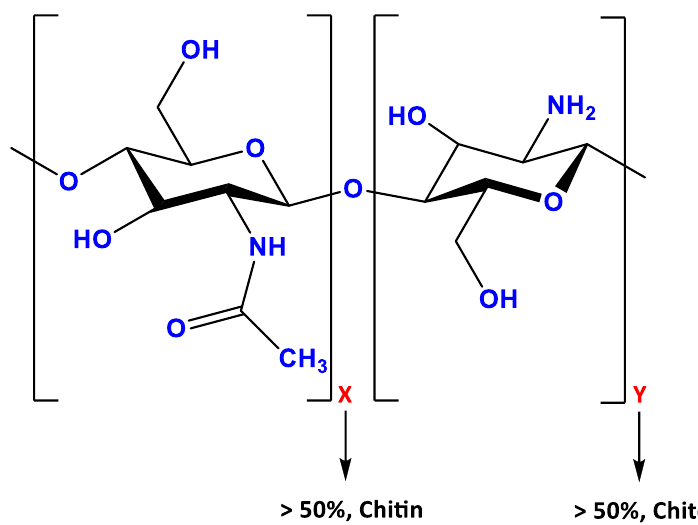
Figure 2. Chemical structure of chitosan. X and Y indicates the glucosamine and acetyglucosamine polymer, respectively.